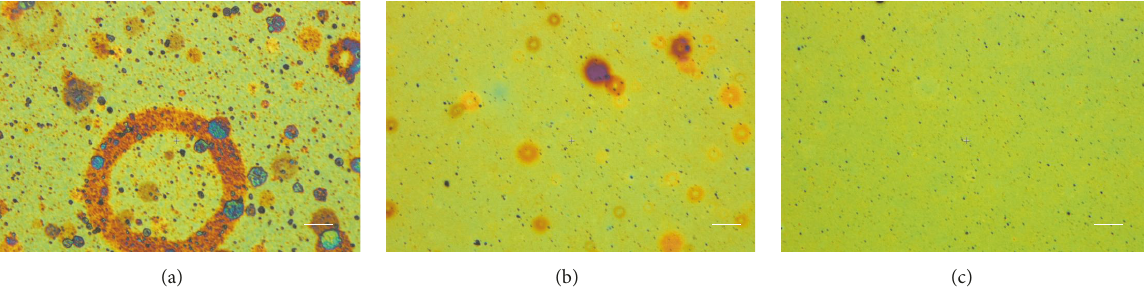
Figure 2: Optical microscope images of the surface of ZnO thin films obtained by electrospray at 18kV and substrate temperature of 150 ∘ C